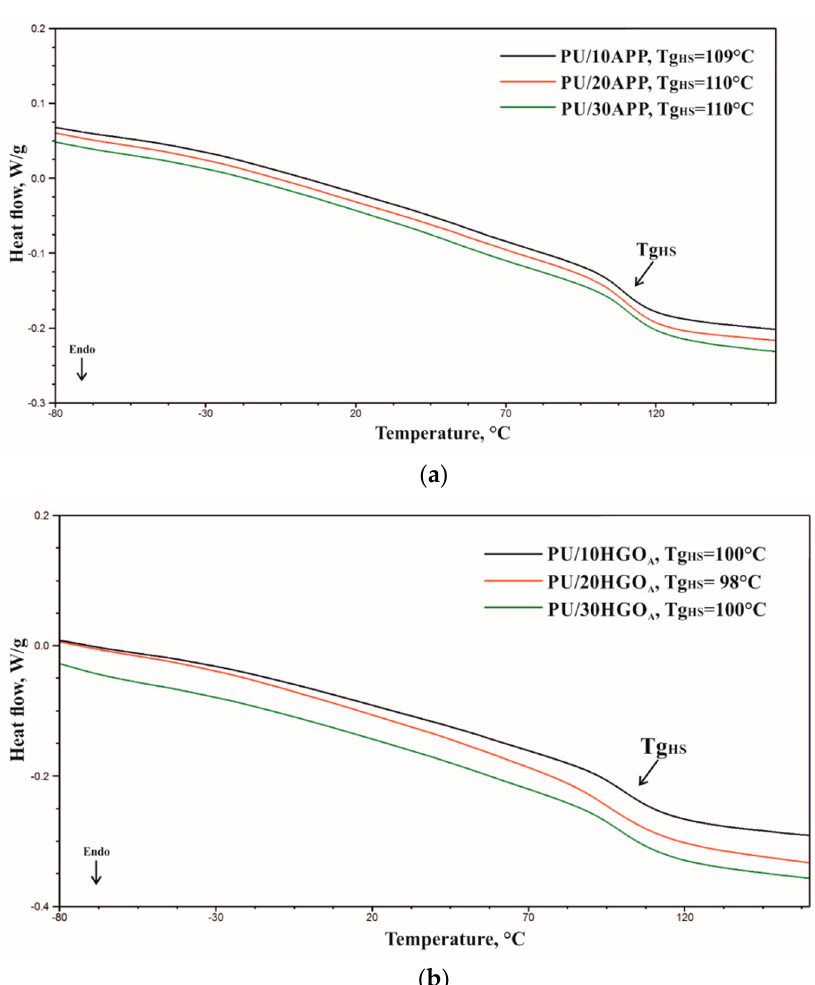
Figure 8. Tg HS of materials ( a ) PU/APP ( b ) PU/ HGO A .